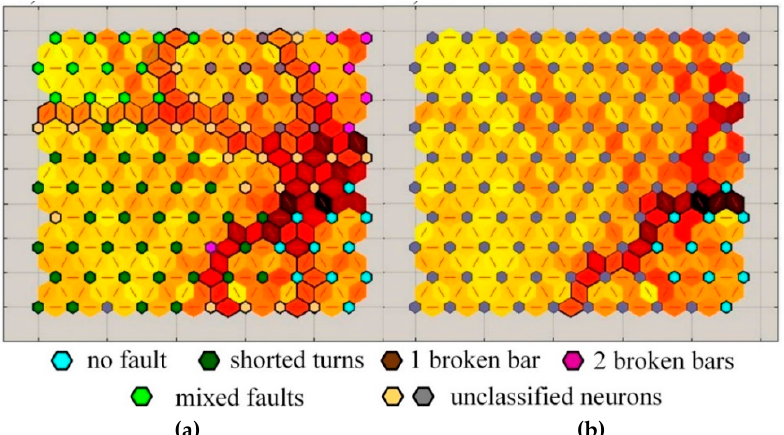
Figure 10. Influence of the learning rate to the SOM neighbourhood distances: ( a ) η = 0.8; ( b ) η = 0.3.